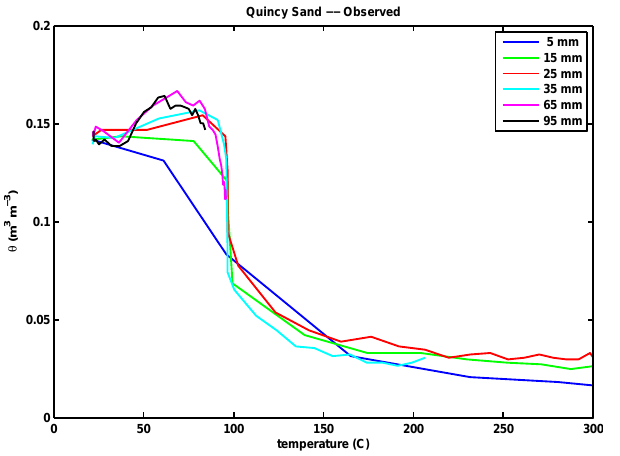
Figure 3. Measured soil moisture vs measured soil temperatures for the Quincy Sand heating experiment (see previous two figures).